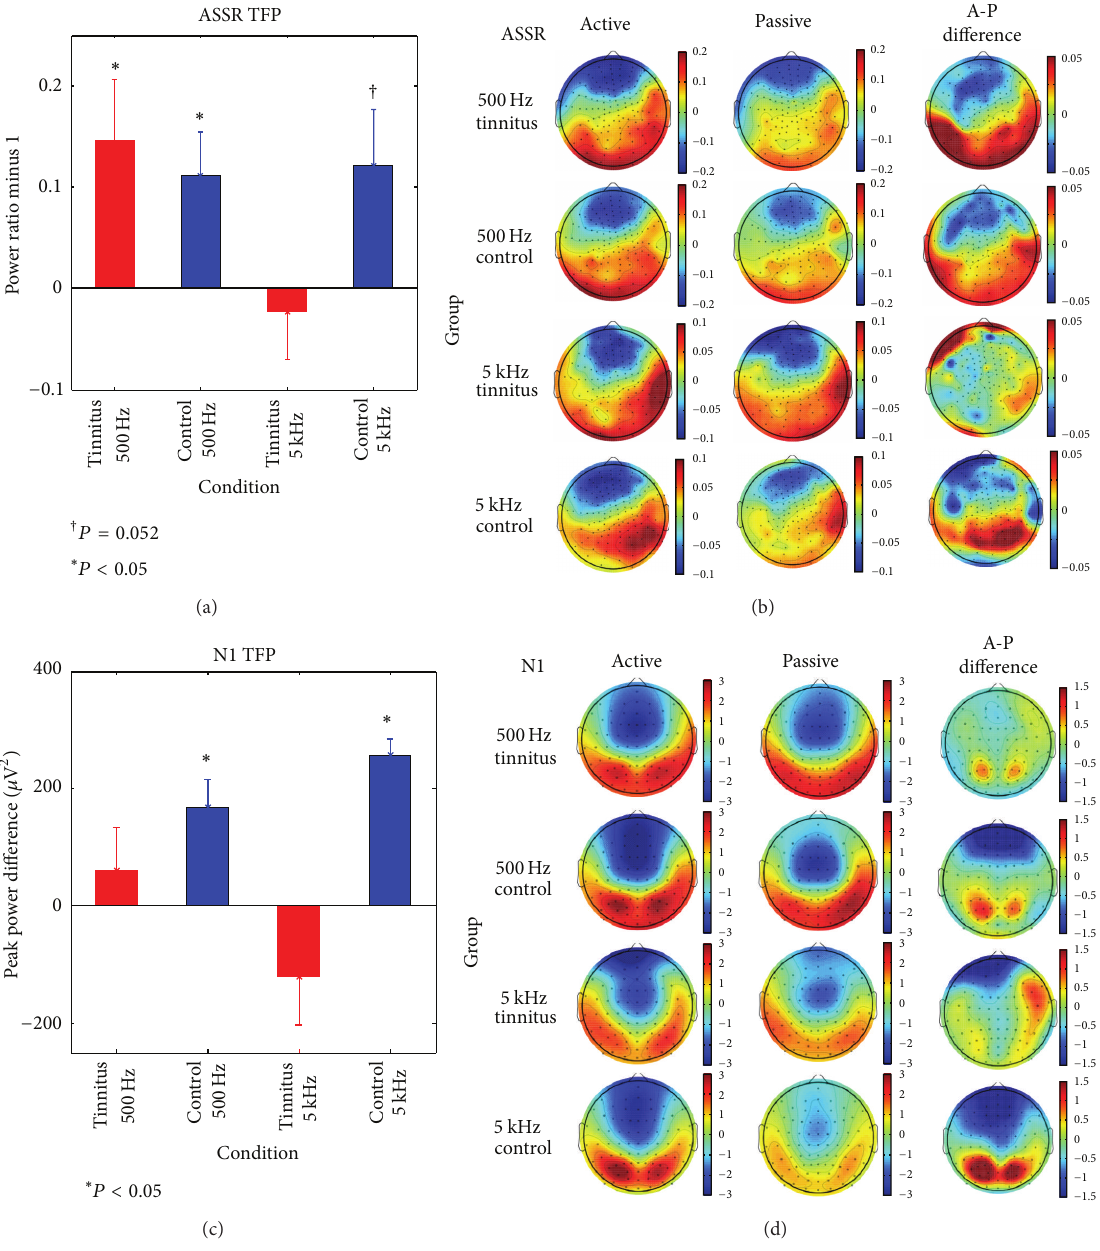
Figure 5: ASSR and N1 attention effects. (a) Effect of attention on ASSR TFP in each group (A/P TFP-1). (b) Voltage map of the ASSR taken at the time point of maximum total field power on active and passive blocks and the voltage difference map (active-passive blocks). (c) Effect of attention on N1 TFP in each group (active-passive blocks). (d) Active, passive, and difference voltage maps for N1 at the peak latency of electrode Fz. The error bars in (a) and (c) are one standard error ( ∗ 𝑃 < 0.05 ; † 𝑃 = 0.052 ).